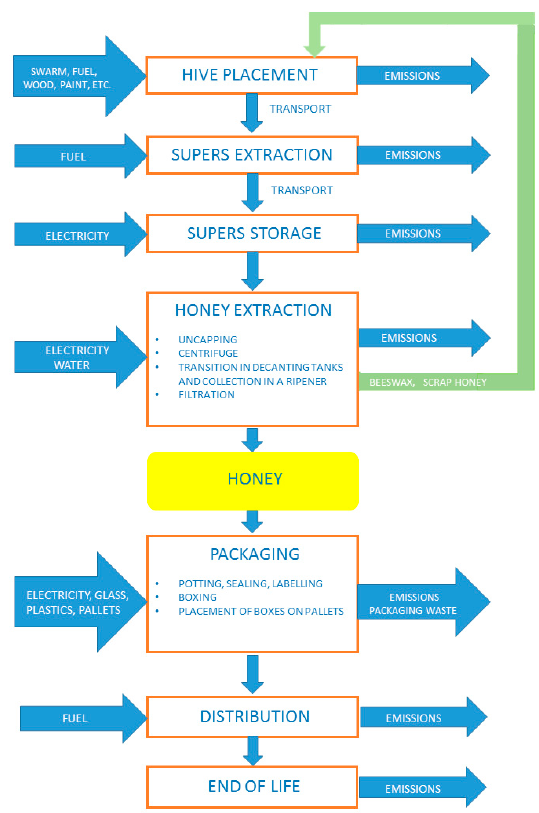
Figure 1. Simplified life cycle flow chart of the product under study (orange-blossom honey—elaborated by the authors).